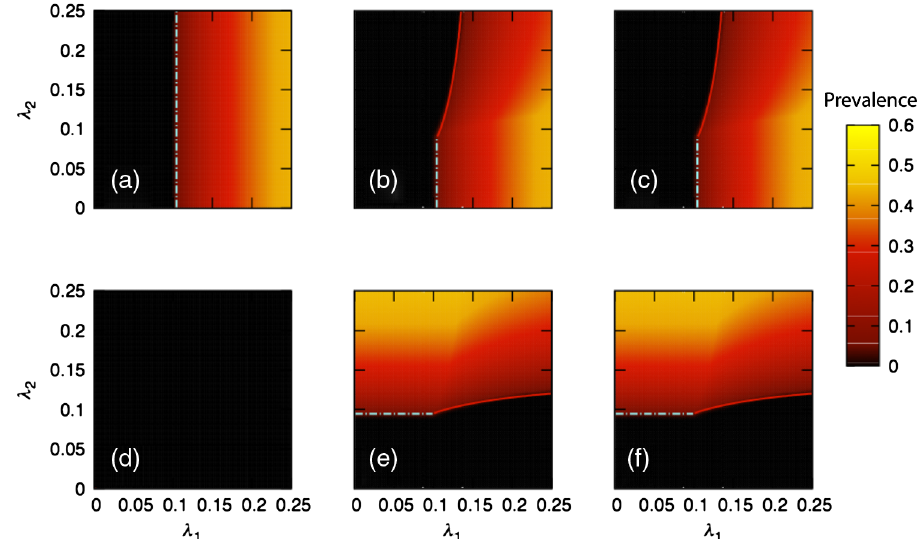
FIG. 3. Reciprocally impaired spreading. Dynamical parameters: μ 1 ¼ μ 2 ¼ 0 . 75 , β a 1 ¼ β b 1 ¼ β a 2 ¼ β b 2 ¼ 0 . 8 , η 1 ¼ η 2 ¼ 1 . 3 . Networks: Erdös-Renyi graphs: N 1 ¼ N 2 ¼ 5000 agents, h k i ¼ 7 , h l i ¼ 8 . The color maps represent the prevalence levels of disease 1 (upper panels) and disease 2 (lower panels) at different stages of the Monte Carlo simulations. As in Fig. 2, we successively introduce three infectious seeds ð IS; SI; IS Þ ¼ ð 0 . 005 ; 0 . 005 ; 0 . 005 Þ and plot the stationary prevalences after each fluctuation in the three columns of the figure. As can be seen, the reintroduction of the third seed of infection 1 in the system does not affect the prevalence levels, as global stability is reached after the second